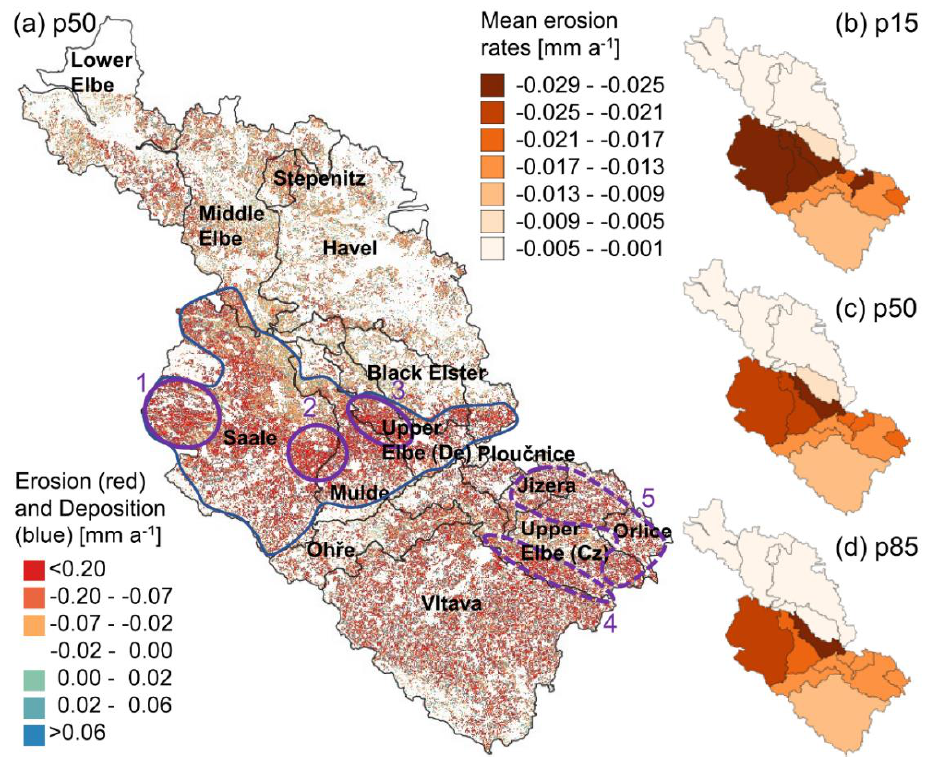
Figure 3. ( a ) Spatial distribution of erosion and deposition rates in the Elbe basin modeled with WaTEM/SEDEM. The map shows the 50th percentile of the 23 Pareto optimal simulations. Zones with the highest erosion rates are highlighted in blue and purple; find more information in Section 3.3. ( b – d ) Erosion rates averaged for the subcatchments. The maps show the 15th, the 50th and the 85th percentile of all optimal simulations.